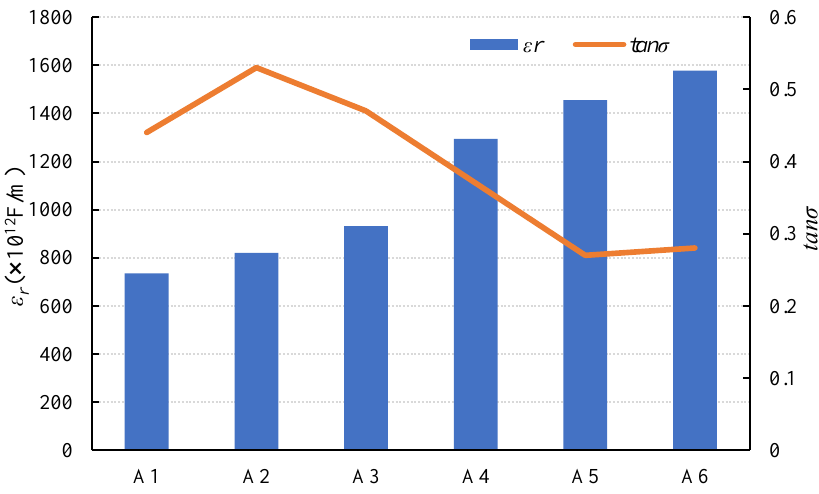
Figure 4. Changes in dielectric properties of specimens with SL/FA.